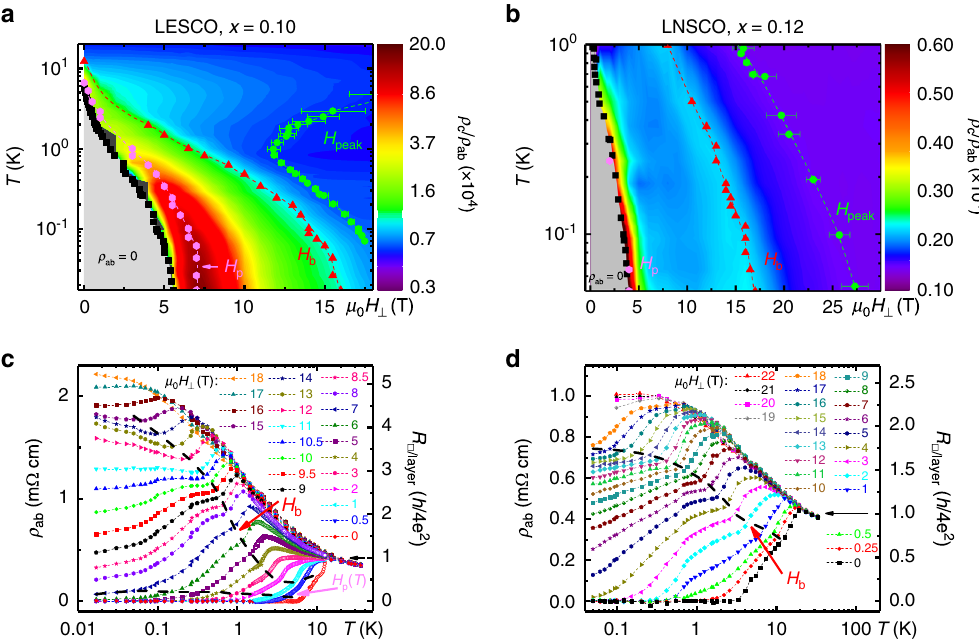
Fig. 2 Anisotropy and the in-plane resistivity for different T and H ⊥ . The color map in a and b shows ρ c / ρ ab in La 1.8 − x Eu 0.2 Sr x CuO 4 (LESCO) with x = 0.10 (data from Fig. 1c) and La 1.6 − x Nd 0.4 Sr x CuO 4 (LNSCO) with x = 0.12, respectively. Black squares: T c ( H ⊥ ); ρ ab = 0 for all T < T c ( H ⊥ ). Green dots: H peak ( T ), i.e. fi elds above which the in-plane MR changes from positive to negative; it has been established 23 that H bars re fl ect the uncertainty in de fi ning the MR peak within our experimental resolution (see inset of Supplementary Fig. 2a for an example; also see Supplementary Fig. 6a and ref. 23 for the raw MR data). Pink dots: H p ( T ), the layer decoupling fi eld; red triangles: H b ( T ), where SC correlations are established in the planes as the SC transition is approached from the normal state. ρ ab ( T ) of c La 1.7 Eu 0.2 Sr 0.1 CuO 4 and d La 1.48 Nd 0.4 Sr 0.12 CuO 4 for several H ⊥ , as shown. Open symbols in c show the data from another run. Short-dashed lines guide the eye. The represented by the black dashed lines, as shown. The lower black dashed line in c corresponds to the layer decoupling fi eld, H p ( T ). In d , H p ( T ) ≳ H c ( T ) [or T H ⊥ )]. Black arrows in c and d show that the splitting of the c (